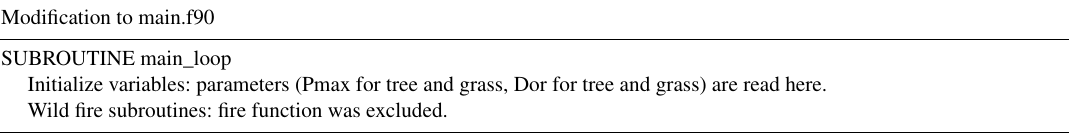
Table A1. List of modifications to SEIB-DGVM